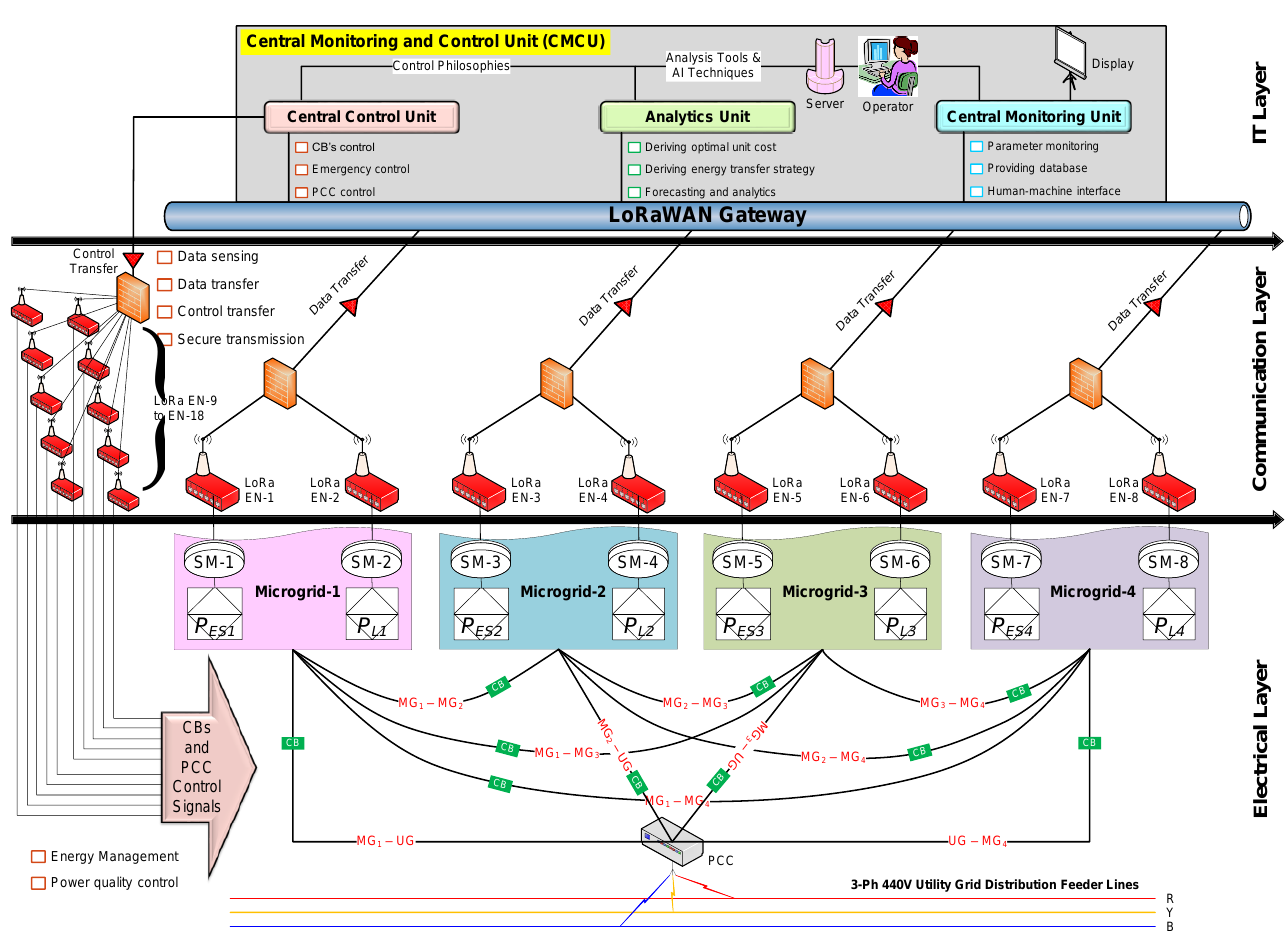
Figure 18. Three-layer representation of ISM architecture.